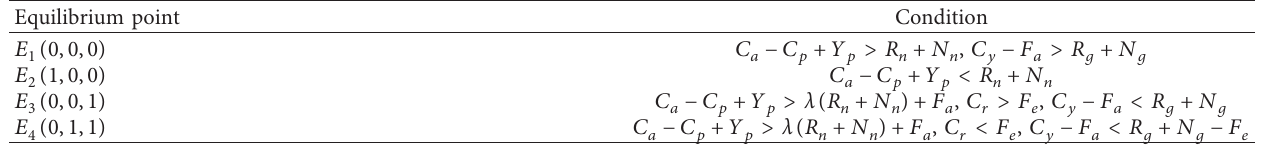
Table 3: The condition of equilibrium point’